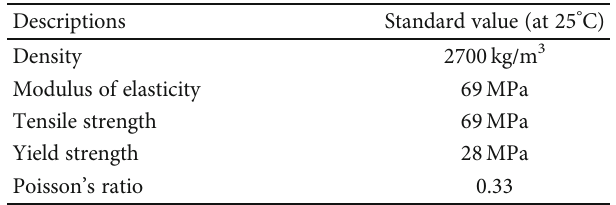
Figure 2: Velocity vector diagram with reactions in the blade [43]. Table 1: Aluminum alloy